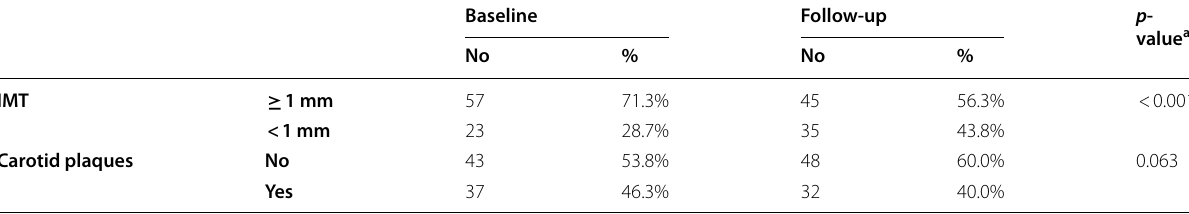
1 mm and carotid plaques ≥